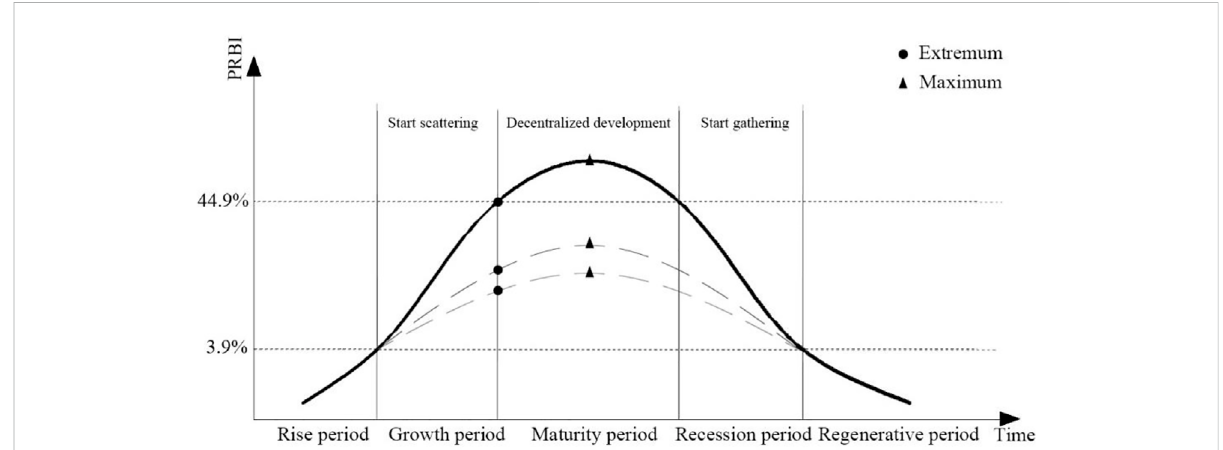
FIGURE 8 The identi fi cation of the resource-based urban development stage. Each line in the fi gure represents the life cycle trajectory of different RBCs, and the dotted line indicates that some cities cannot exceed a PRBI of 44.9% during their life